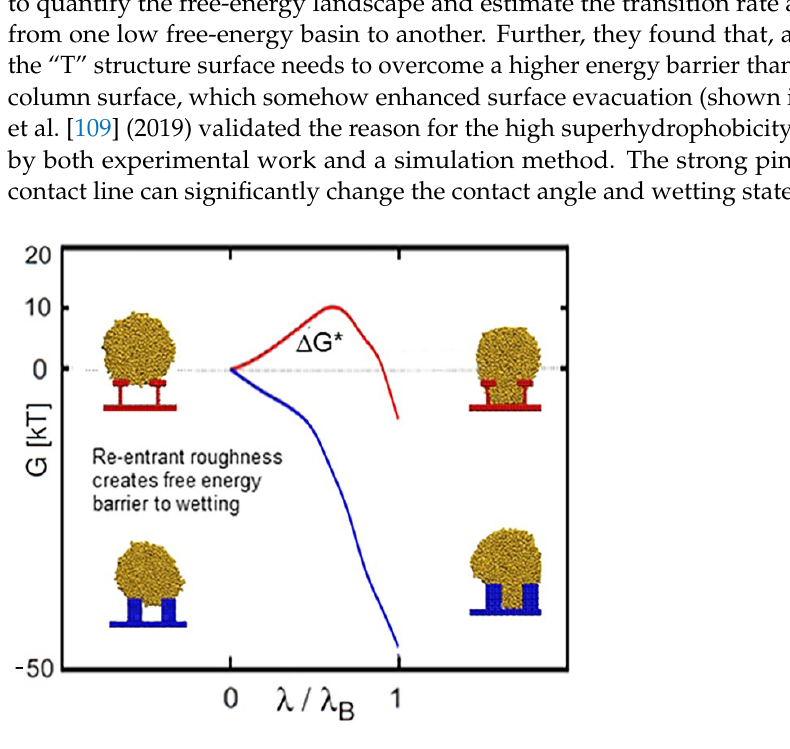
Figure 7. Stability analysis of the composite interface consisting of a rough surface with two- dimensional pillars with semi-circular grooves. Reprinted with permission from Ref. [103]. Copy- right@2009, Elsevier Ltd.